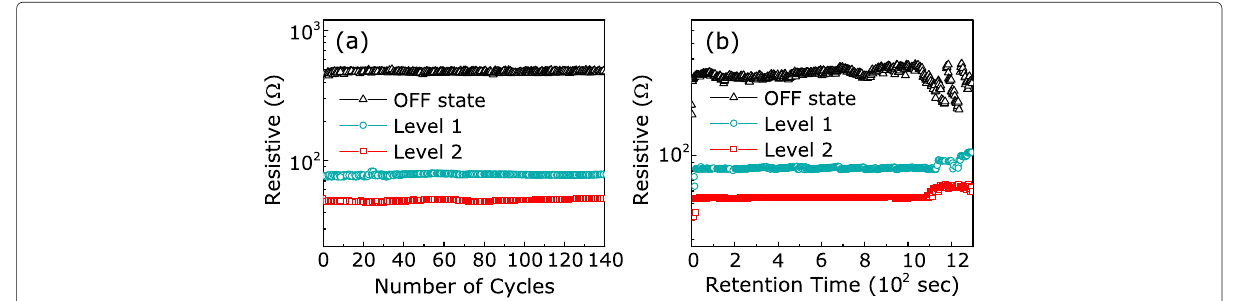
Fig. 4 a Pulse cycles up to 140 times and b time up to about 1200 s for HRS and LRS measurements in the Au/KCl-MAPIC/ITO/glass device at room